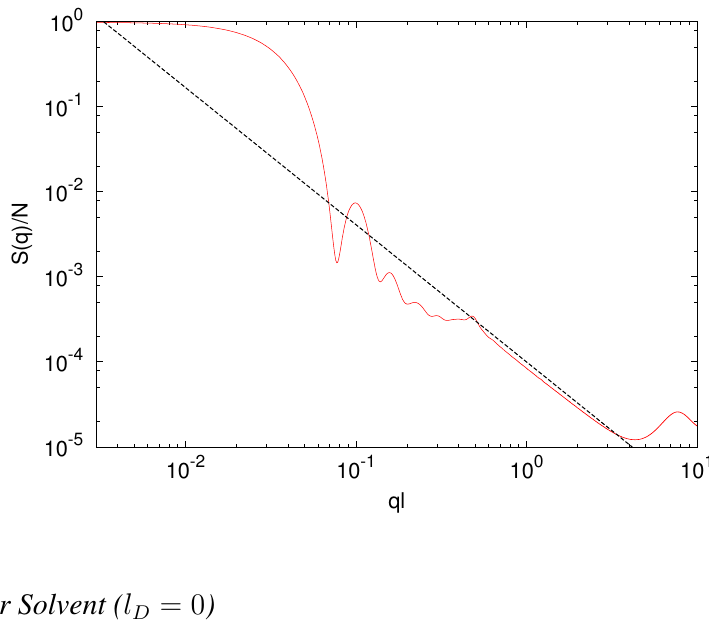
= 40 . The dashed line is proportional to q − 1 / 0 . 62 m